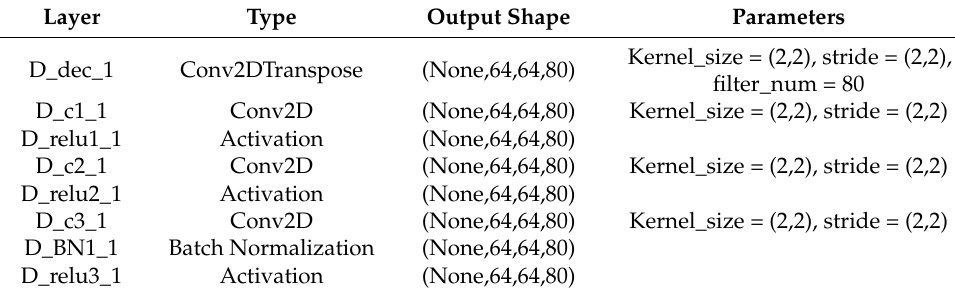
Table 2. The first block structure in the decoding